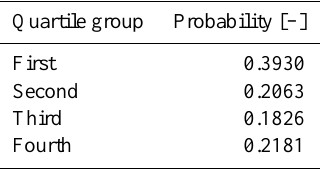
Table 4. Probability of a storm to belong to a certain quartile